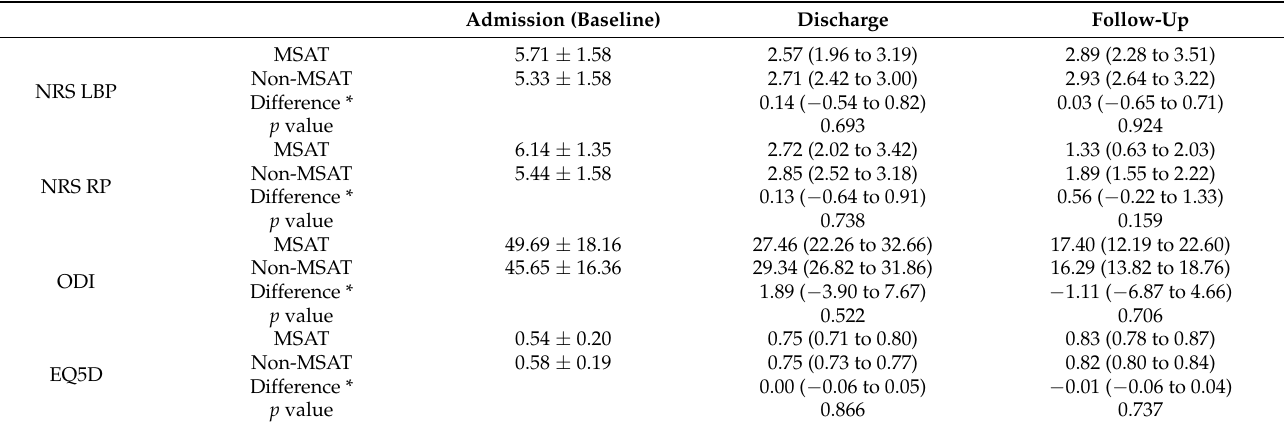
Table 4. Difference in outcome at each time point between two